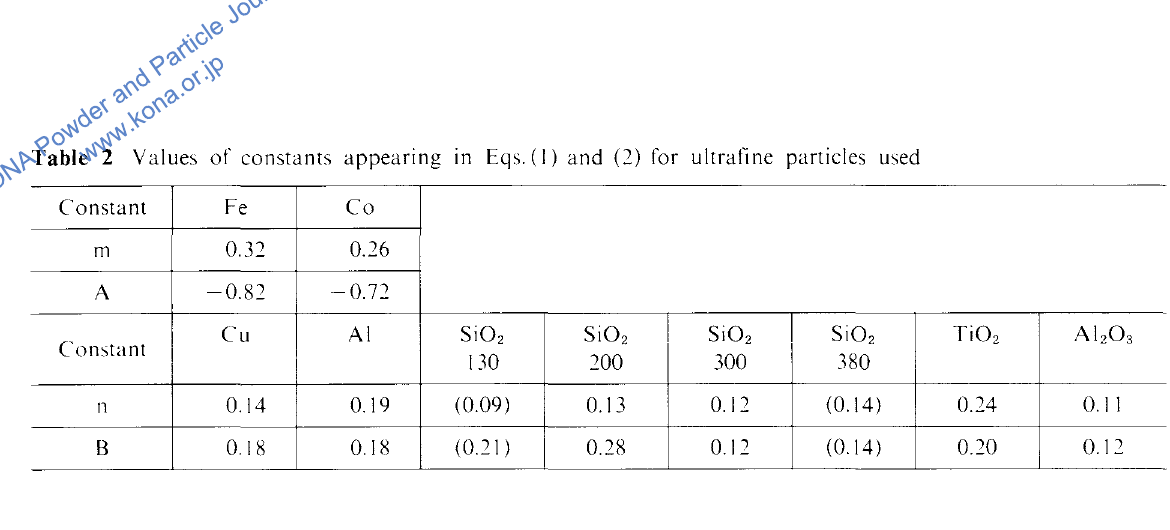
Table 2 Values of constants appearing in Eqs. (I) and (2) for ultrafine particles